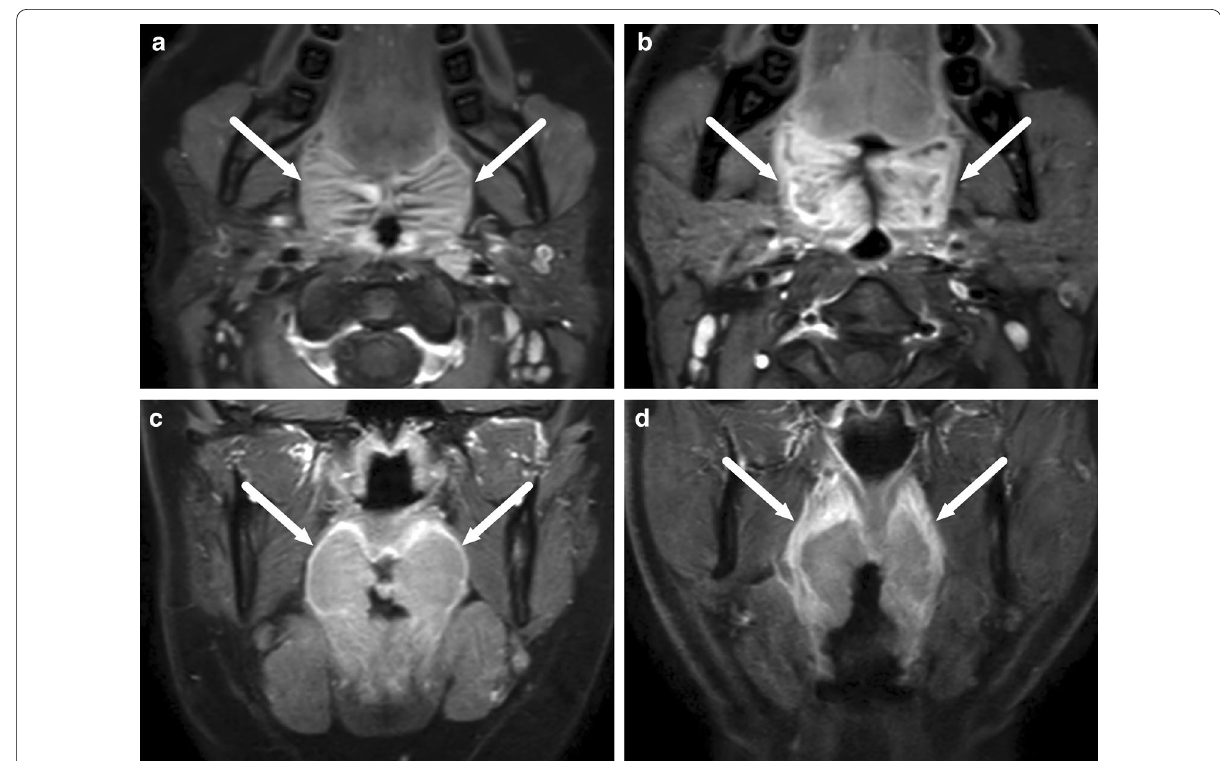
Fig. 13 Tonsillitis/peritonsillitis on axial ( a , b ) and coronal ( c , d ) post-contrast T1-weighted images in two patients ( a and c , b and d ). Note the striped appearance of the tonsils (arrows in a ), peritonsillar enhancement (arrows in b – d ), and no abscess